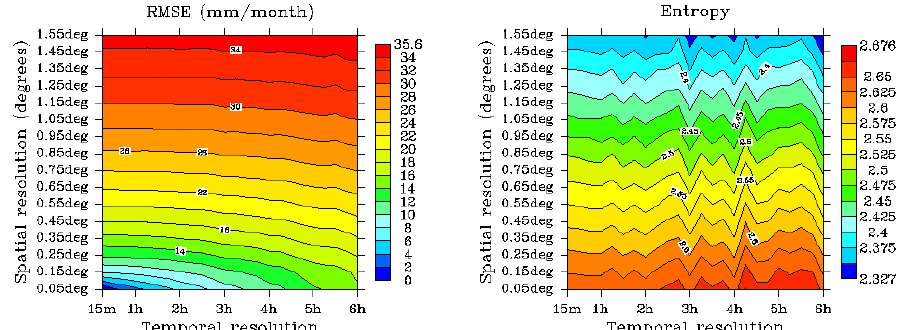
Figure 5. Correlation (r 2 ), RMSE (mm/month), bias (mm/month) and entropy (arbitrary units) departures from the perfect geostationary microwave simulation at different spatial and temporal resolution.